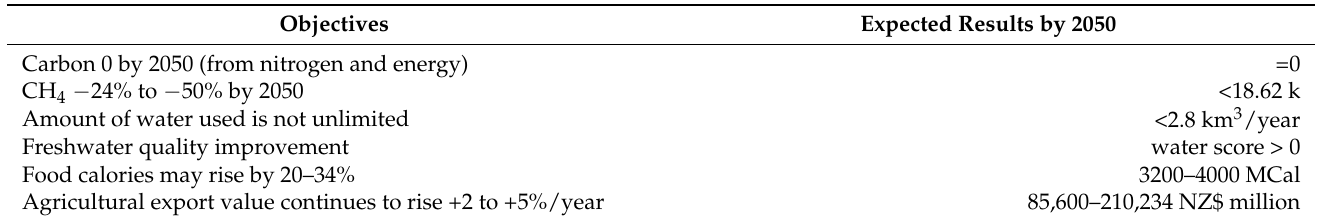
Table 4. Quantitative objectives and expected results for a sustainable, resilient, and profitable system.